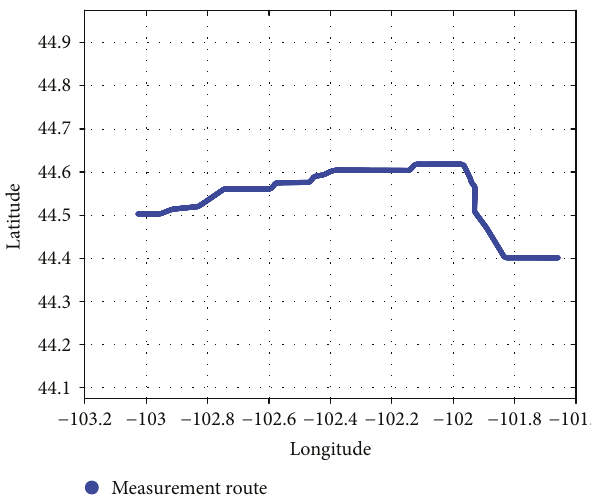
Figure 2: Three locations of clusters with respect to Tx and Rx (Note that v the distance between clusters and Tx/Rx antenna elements, respectively; ρ and h are the density and average height of clusters, respectively; and the symbol a is the average distance from vehicles Tx/Rx to the left/right roadside.)